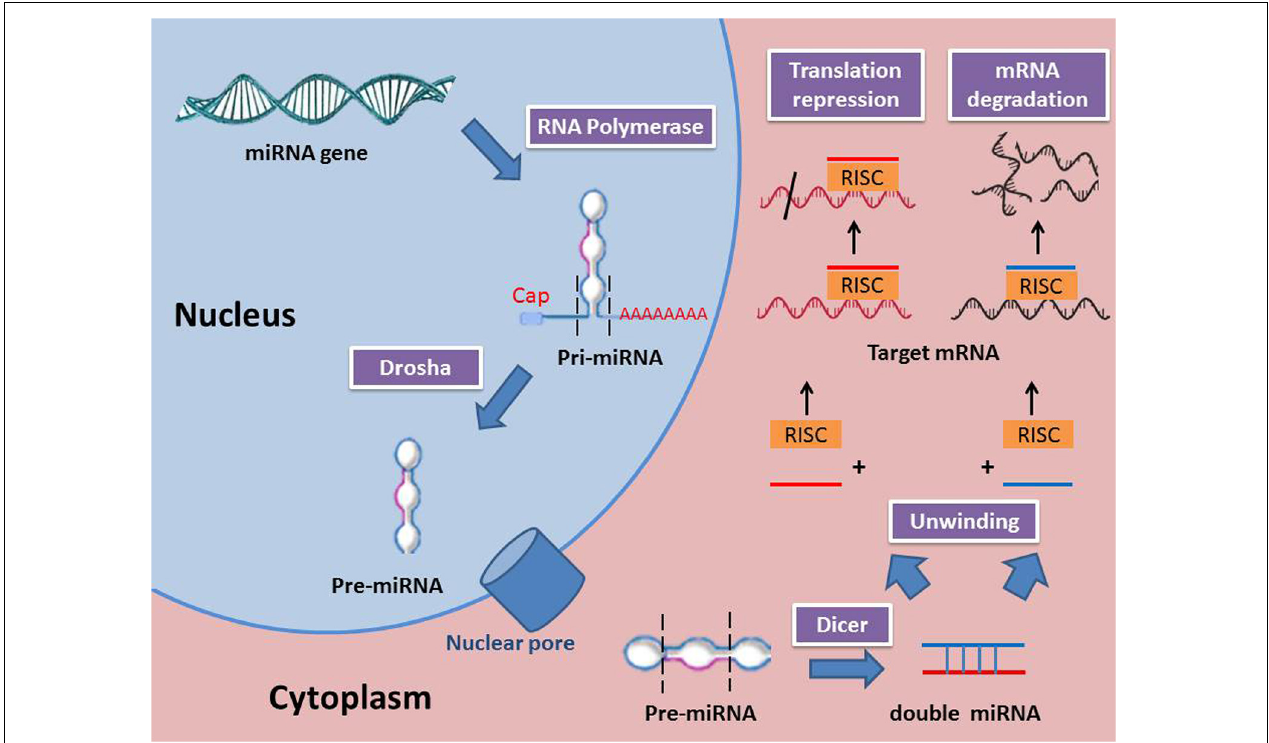
FIGURE 1 | miRNA biogenesis and mechanisms of action (RISC, RNA-induced silencing complex; Pri-miRNA, Primary miRNA; Pre-miRNA, precursor miRNA).